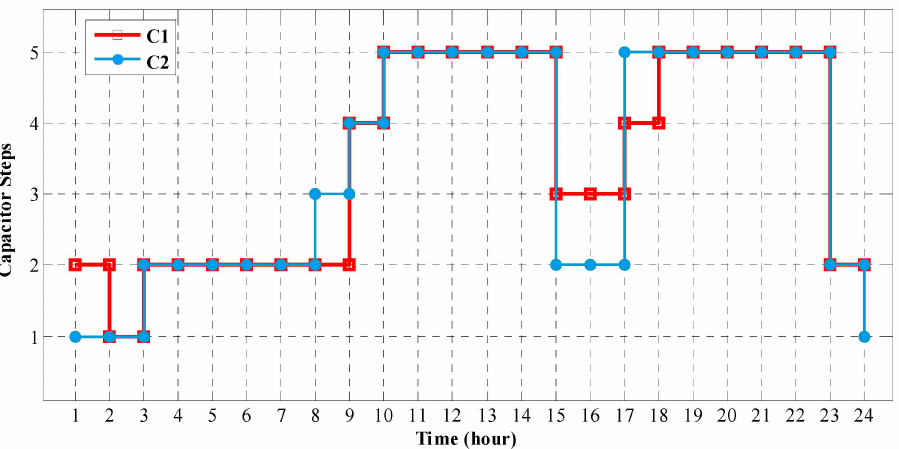
Figure 11. Optimal dispatches of the capacitors C1 and C2 for day-ahead in Scenario 1.